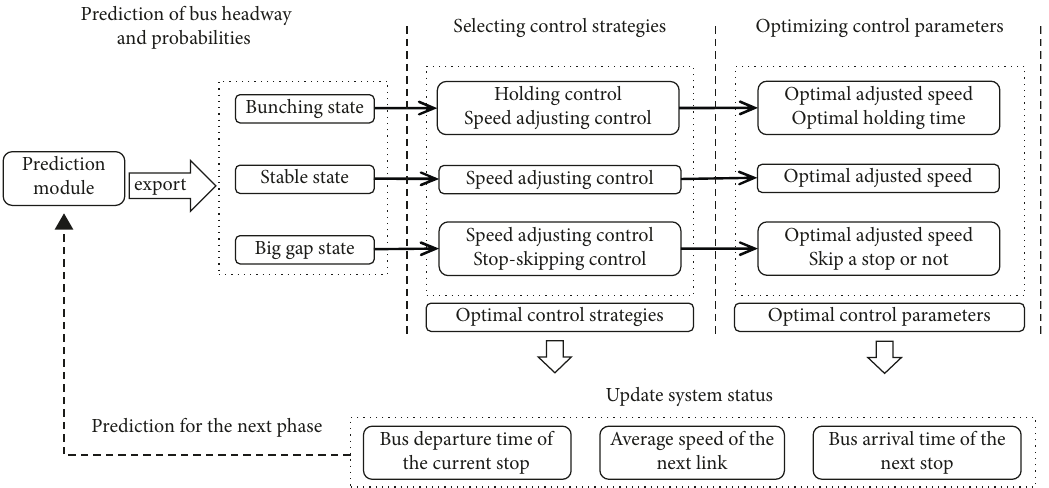
Figure 5: Principle of the combined control